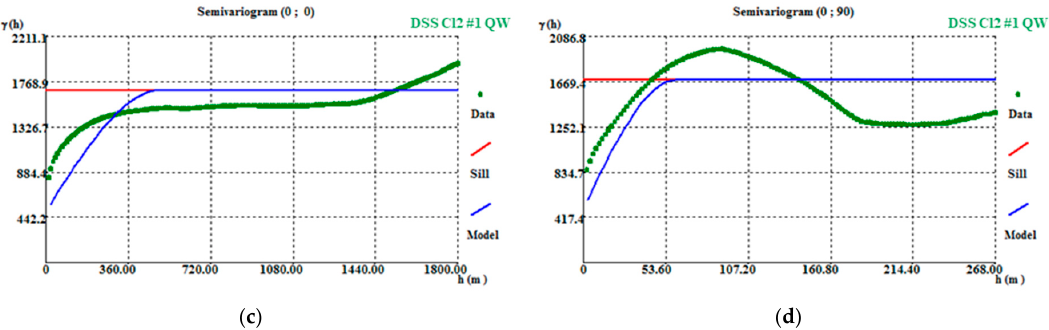
Figure A12. Step 3 DSS output variogram adjustment applied to the first simulated scenario: ( a ) CL1 DSS horizontal variogram; ( b ) CL1 DSS vertical variogram; ( c ) CL2 DSS horizontal variogram; ( d ) CL2 DSS vertical variogram. Table A11. Wolframite quantity statistical analysis comparison—initial data set and Probability Field Simulation first scenario.